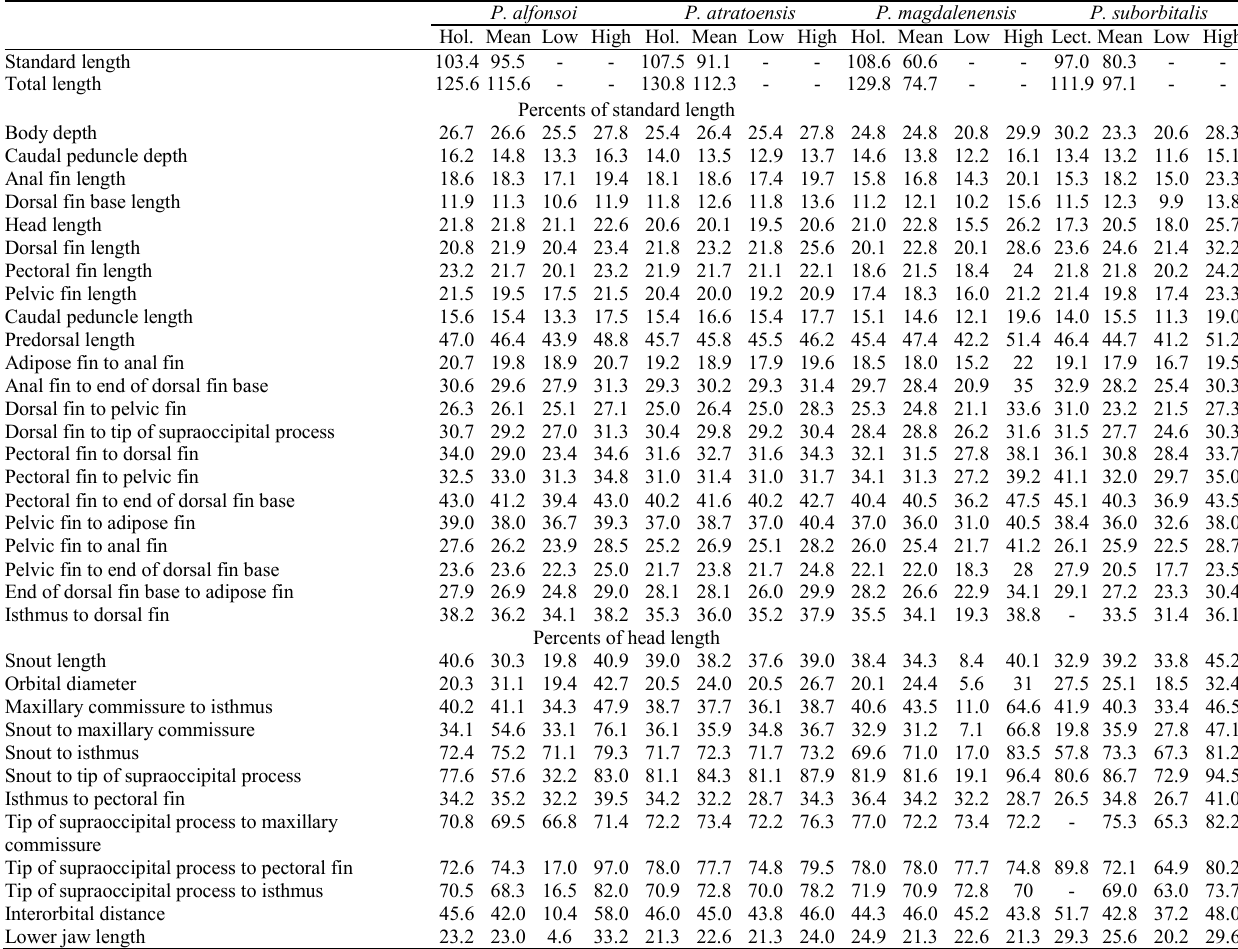
Table 1. Morphometric measurements as percent of SL and HL for Parodon alfonsoi (n = 14), P. atratoensis (n = 5) ,